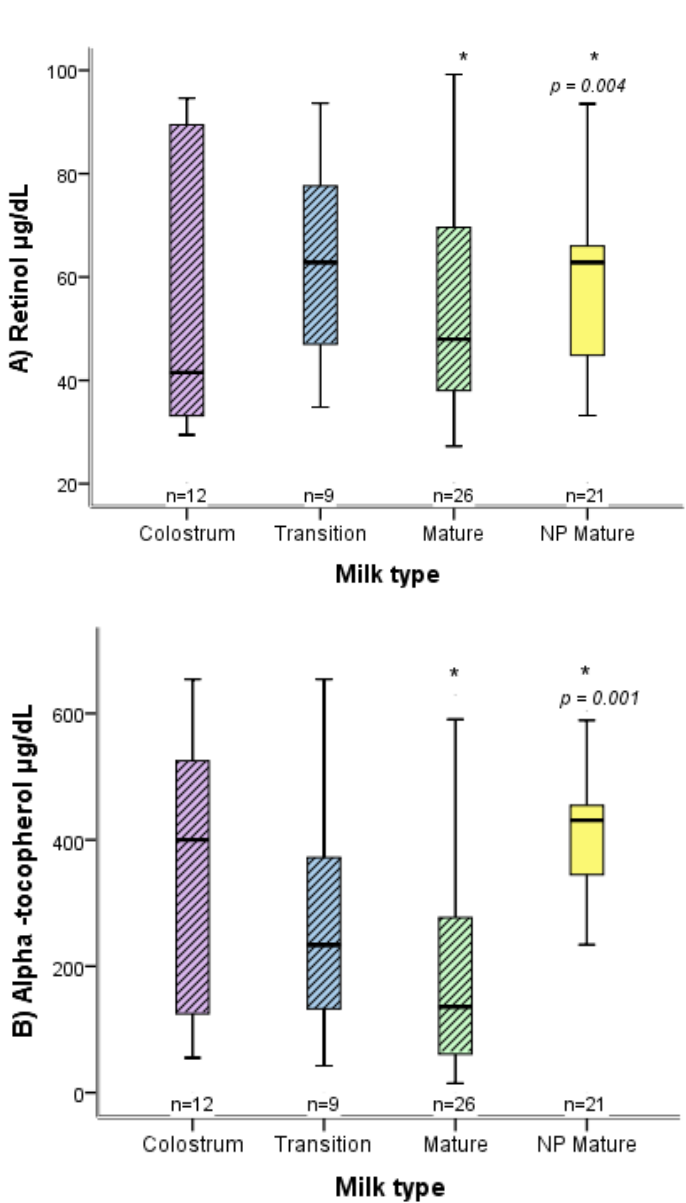
Figure 2. Box plot distribution of the concentration of retinol ( A ) and α -tocopherol ( B ) in breast milk, comparing women with a preterm, high-risk pregnancy to those with a normal pregnancy. For the high-risk pregnancy, the distinct types of breast milk (colostrum, transition milk and mature milk) are shown. * p ; Mann-Whitney U . The bottom and top of the box represent the first and third quartiles (IQR), and the band inside the box the median. The ends of the whiskers denote the lowest and highest values still within 1.5 IQR. Outlier values are not displayed. NP, normal pregnancy.